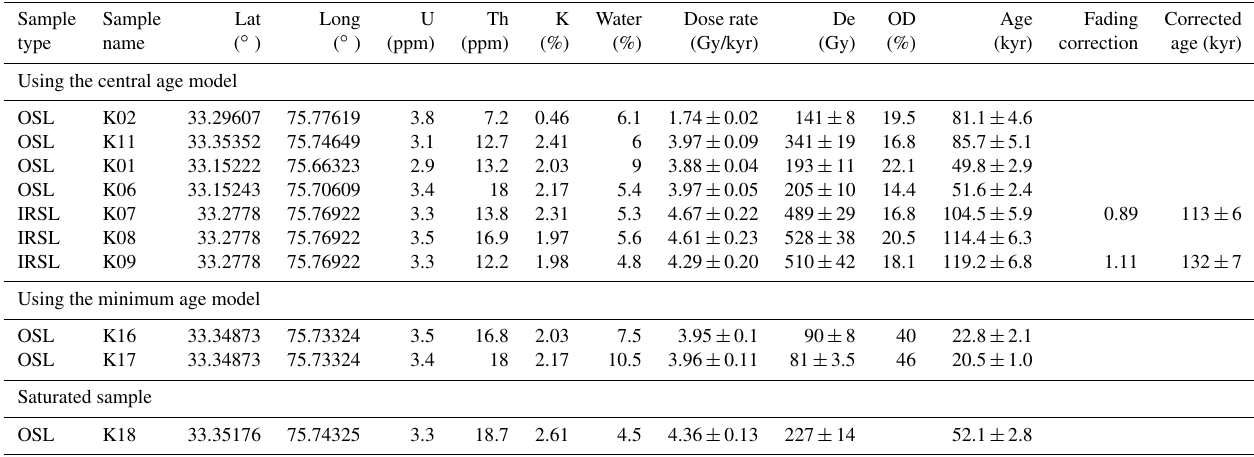
Table 2. Sample locations, elemental concentrations, dose rates, equivalent doses and age estimations for OSL and IRSL analyses of sand samples from Kishtwar